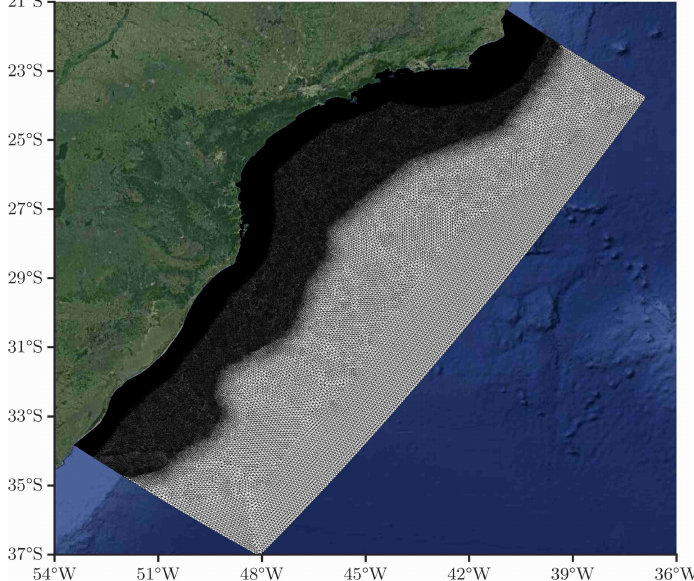
Figure 2. Representation of the numerical grid used for the simulations. Satellite images from maps. google.com .